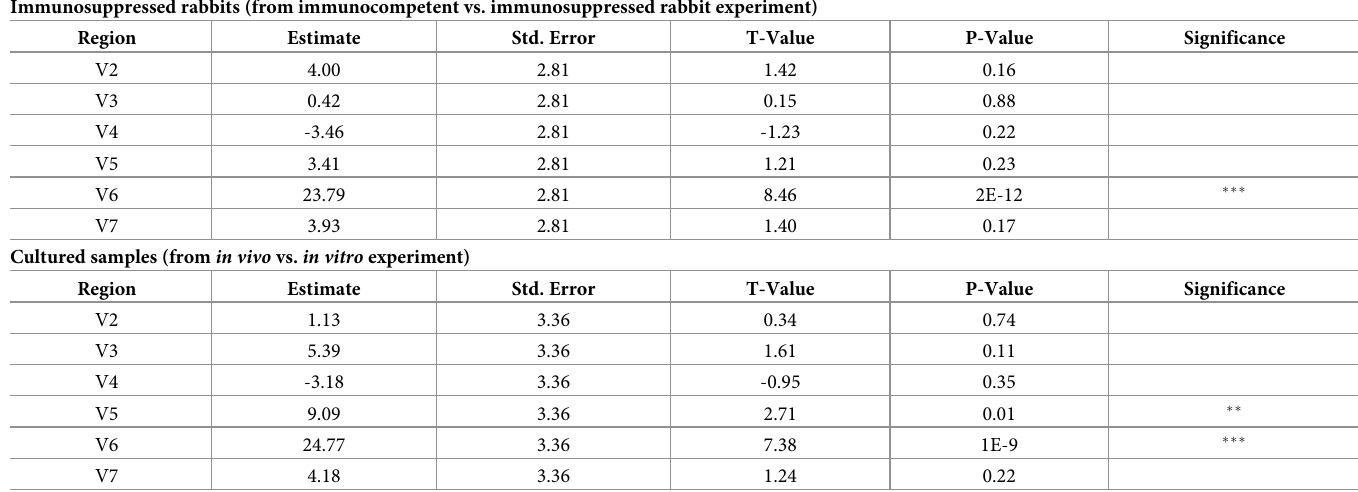
Table 1. Linear mixed model shows significant increase in rate of unique variant generation in V6 in both immunosuppressed rabbits and cultured samples. Change in unique variants in each variable region is compared to V1 for both experiments using T-Tests following Kenward-Roger’s method [29]. Significance is denoted with asterisks (0 ��� , 0.001 �� , 0.01 �